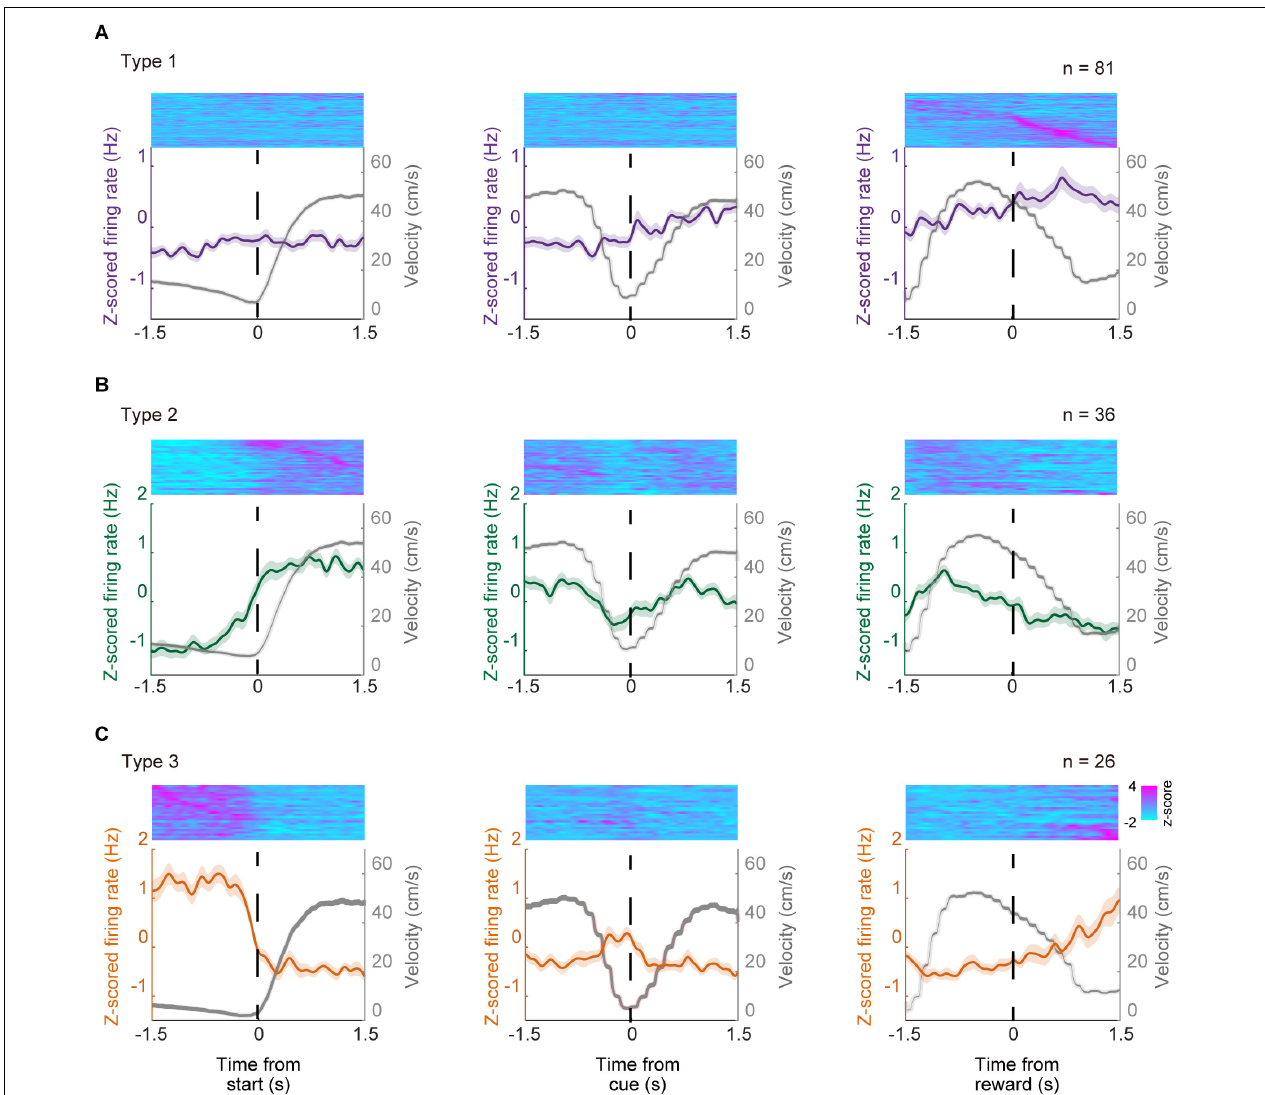
FIGURE 5 | Population activity of type 1–3 neurons. Normalized Z -scored firing rates of phasic ACC neurons; type 1 neurons (A) , type 2 neurons (B) , and type 3 neurons (C) . Normalized firing rate of individual units are shown in the top panels whole PETH that of the mean z -scored firing rate of each neuron type and running velocity are shown in lower panels. Each unit were sorted according to the timing of the maximum value ( ± 1.5 s) relative to the key task events. Z -scored activity profiles were obtained for each neuron by using the instantaneous firing rate for each unit, which was produced by convolving a Gaussian kernel with σ = 50 ms resampled at 100 Hz for each single